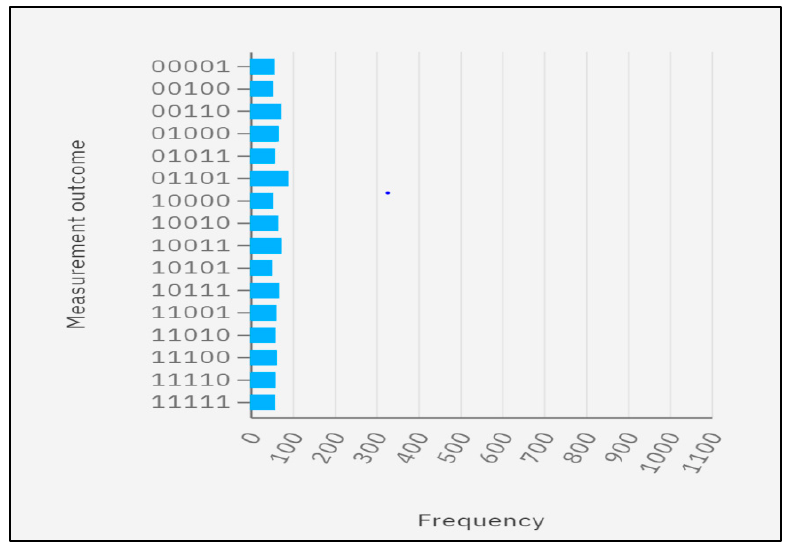
Figure 8. Result 1: Run on simulator which shows the measurement outcomes (probability).